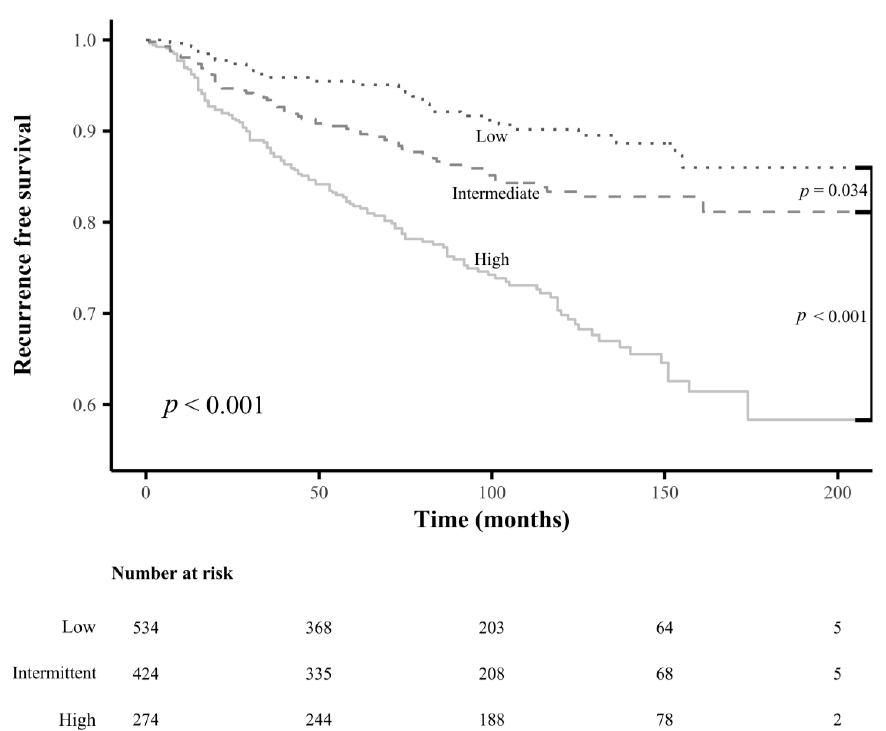
Figure 5. Comparison of the recurrence-free survival rates between the newly developed lymph node-related risk groups. Table 3. Proposal of detailed lymph node-related risk categories for recurrence-free survival